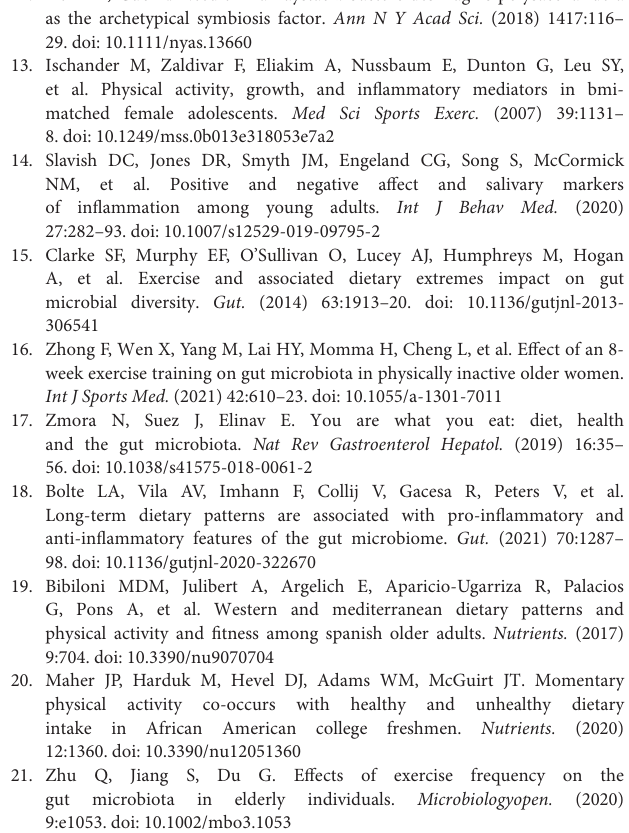
Supplementary Figure S1 | Principal Coordinate Analysis (PCoA) of gut microbiota. (A) unweighted-Unifrac distance metrics; (B) weighted-Unifrac distance metrics. Each point represents a sample, athlete group in blue, high physical activity group in orange, and low physical activity group in green. The two coordinates are plotted and further indicated the percentage of variability on the axis. Supplementary Figure S2 | Beta weighted-Unifrac heatmap. The Gradient color in the heatmap represents the degree of difference of each sample among athletes, high physical activity group, and low physical activity group. The distance between samples indicated increases gradually with the color from blue to red. Supplementary Figure S3 | Differential taxon features were analyzed by linear discriminant analysis (LDA) effect size (LEfSe) analysis among three groups. (A) showing differentially abundant bacterial taxa. (B) indicating LDA scores. Bacterial taxa indicated significantly high when LDA score > 2 or LDA score < -2. Athlete, Athlete group; HPA, High physical activity group; LPA, Low physical activity